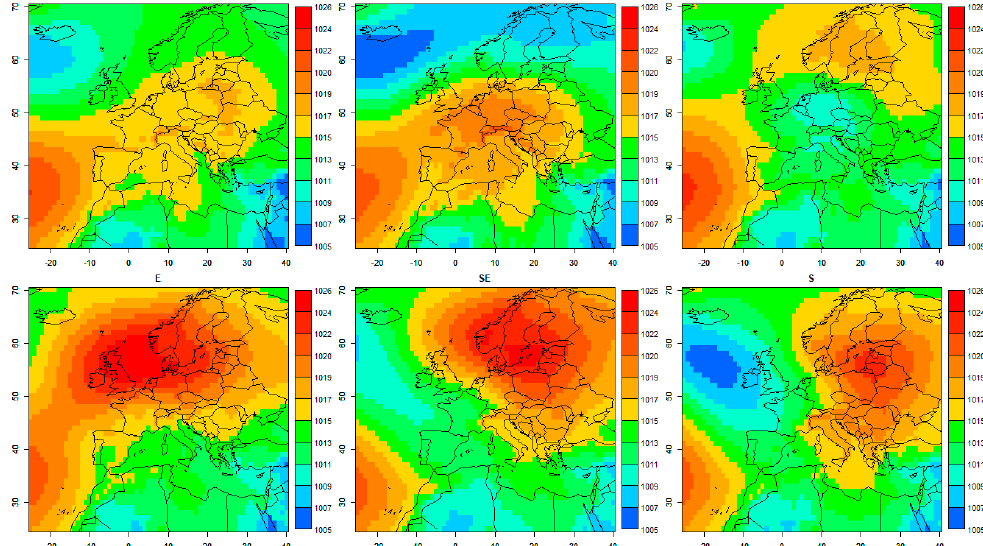
Figure 4. Weather types (mean sea level pressure in hPa) relevant for ozone and heat waves in Bavaria. U: “Unclassified” weather type (mean relative frequency across all wave types: 27.6%) A: Anticyclonic (17.5%), C: Cyclonic (7.3%), E: East (4.4%), SE: Southeast (4.3%), S: South (3.9%).